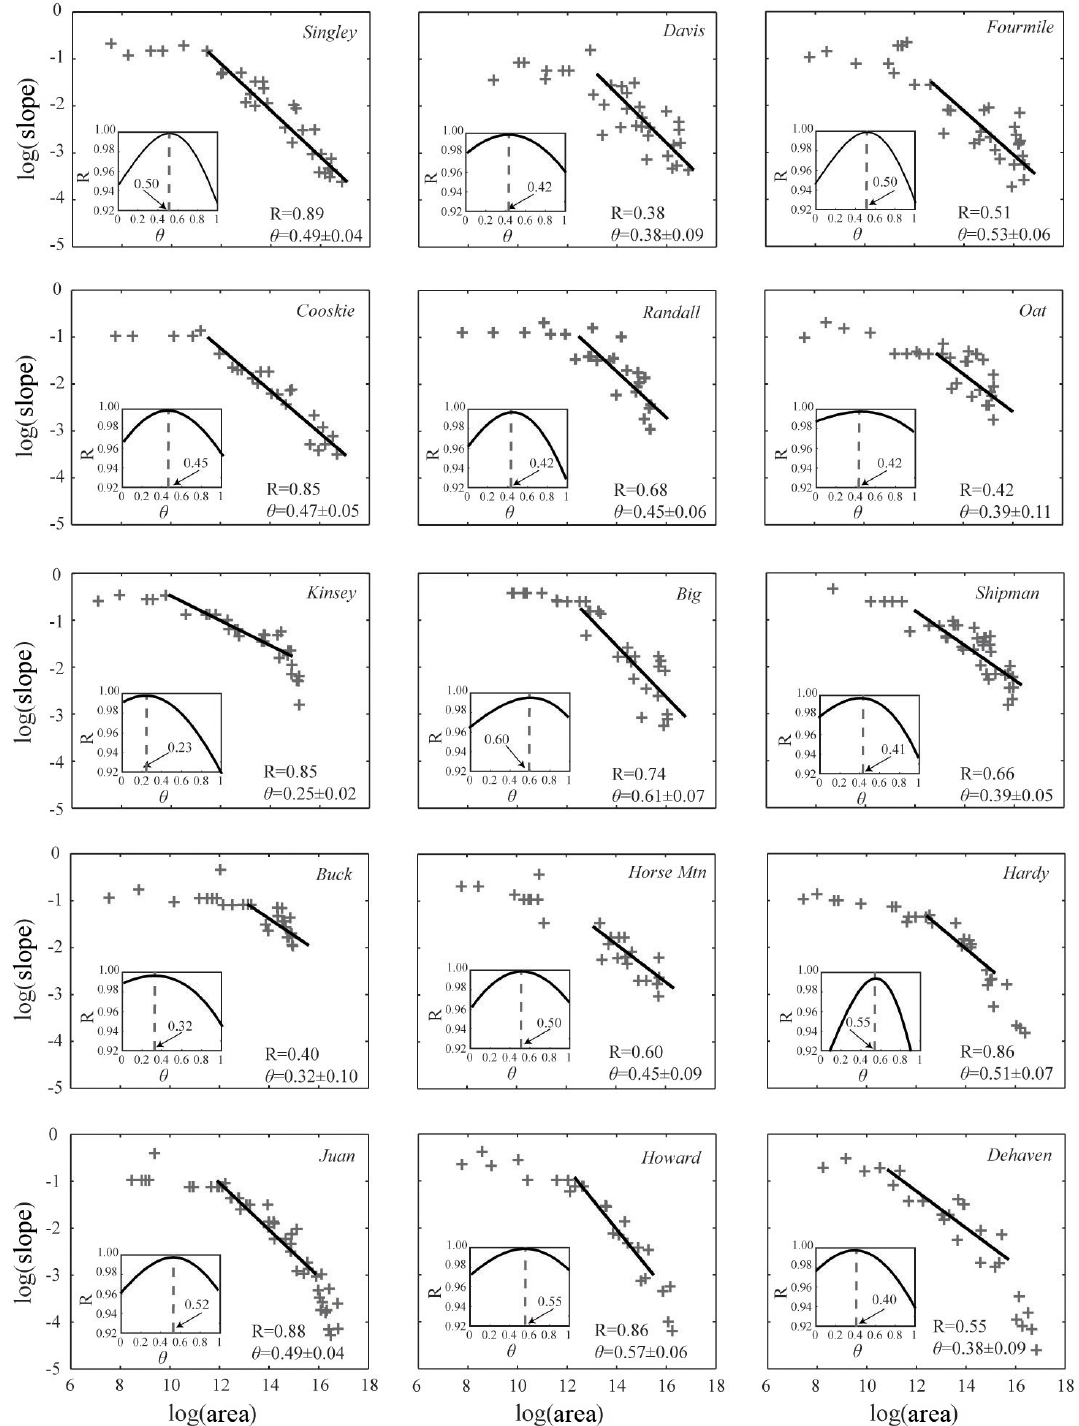
Figure 5. Correlation coefficients derived from slope–area analysis and the integral approach. The slope was derived from the smoothed (horizontal distance of 300m) and re-sampled (elevation interval of 20m) elevation data. The correlation coefficients of χ − z plots as a function of θ for bedrock channels are shown in the bottom left. The mean θ value is